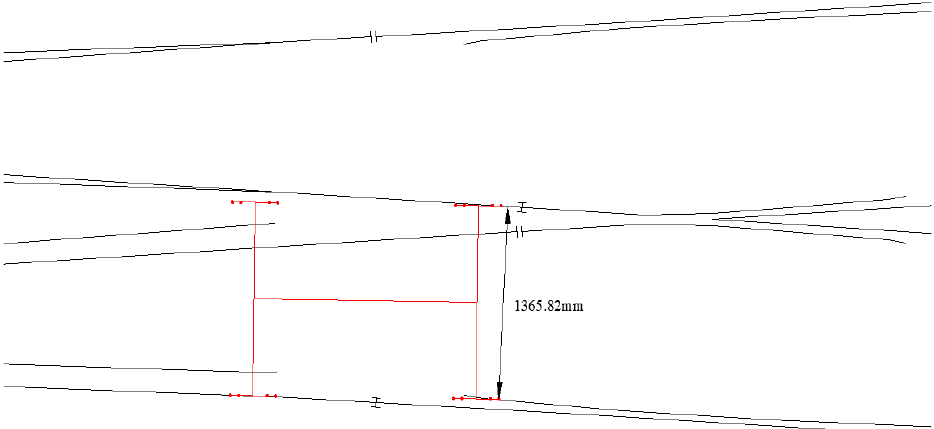
Figure 10. Necessary guardrail interval limit in the acute crossing area of the No. 9 double-slip turnout for 60 kg/m rail (Design Drawing No. SC450) which experienced derailment.